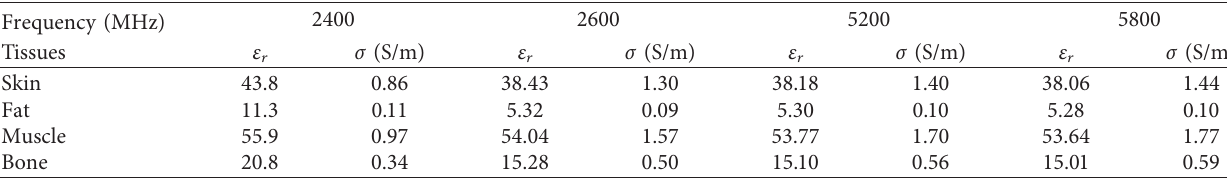
Table 4: Human hand tissue characteristics [19].